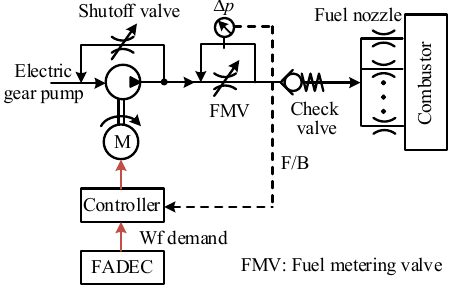
Figure 6. Schematic of MEE system.